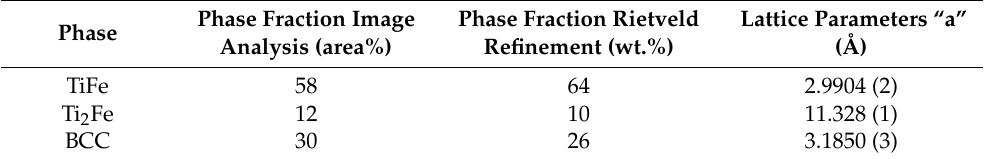
Figure 2. X-ray diffraction patterns of the induction-melted 1.2Ti-0.8Fe. Table 2. Rietveld refinement of the as-cast induction-melted 1.2Ti-0.8Fe (the uncertainty on the last significant digit is given by the number in parentheses).